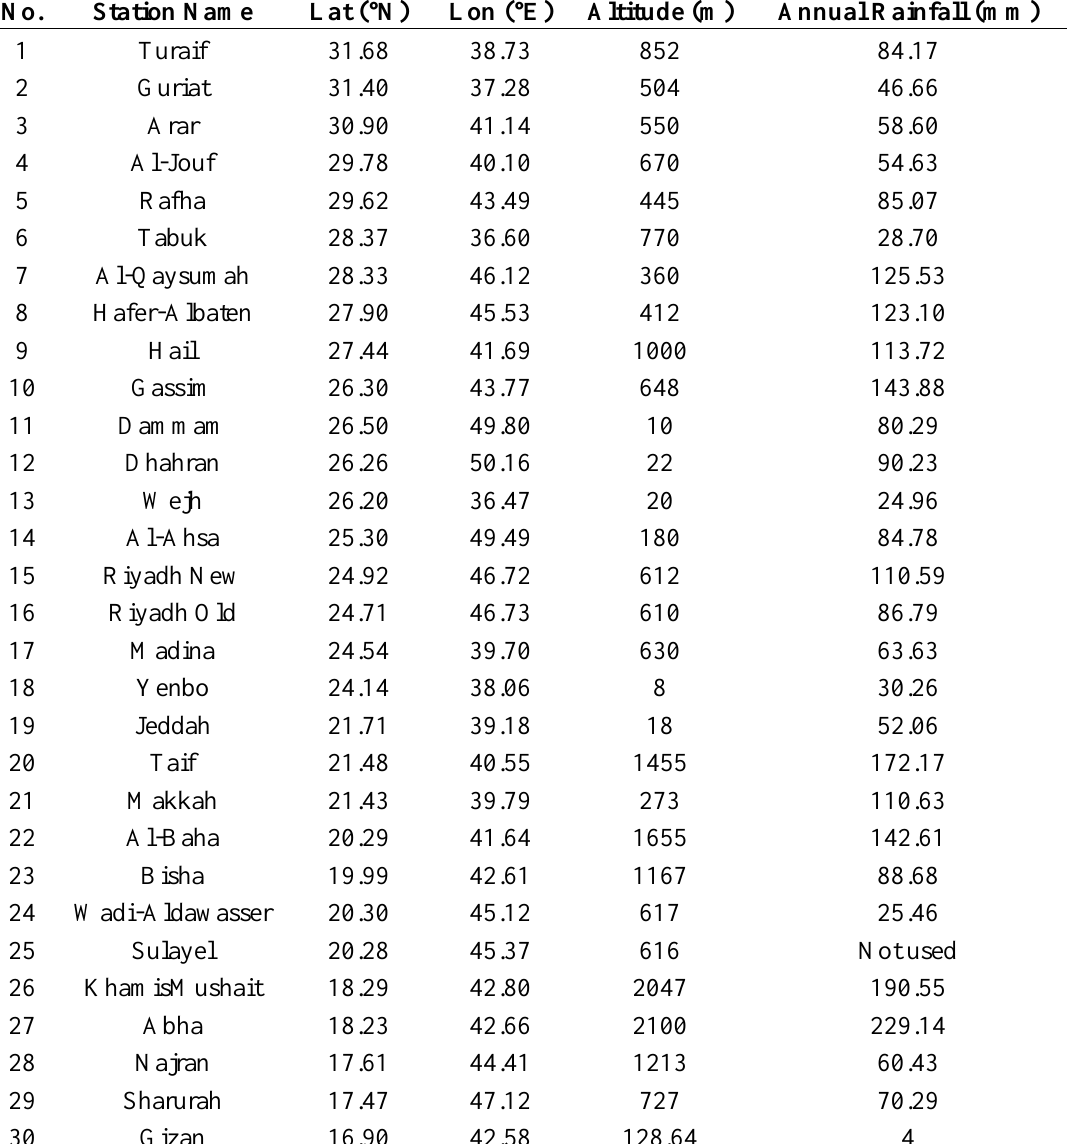
Table 3. The station names with latitude, longitude, altitude and annual rainfall. Serial number (No.) of stations is used